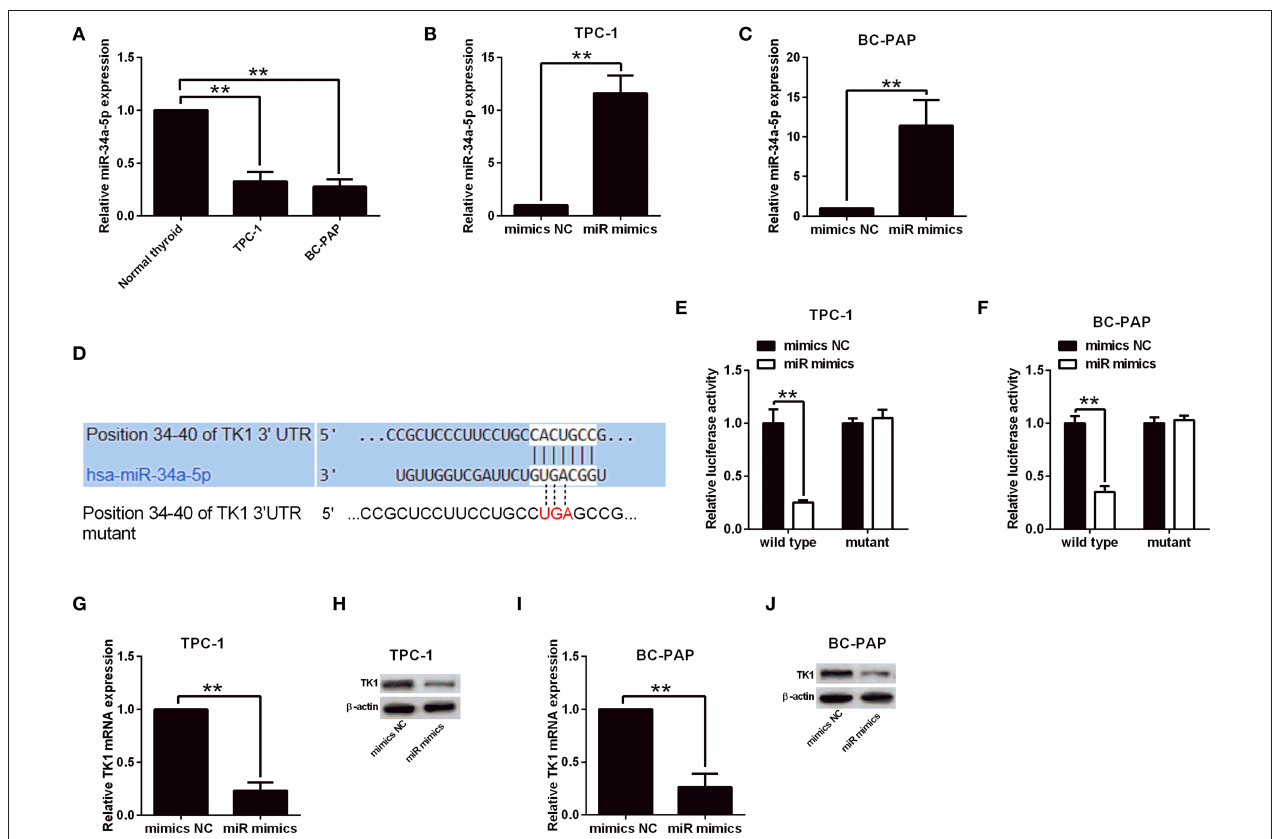
FIGURE 5 | Thymidine kinase 1 (TK1) expression was regulated by miR-34a-5p in thyroid carcinoma cells. (A) Quantitative real-time PCR (qRT-PCR) analysis of miR-34a-5p expression level in normal thyroid follicular epithelial cells, TPC-1 and BC-PAP cells. (B,C) MiR-34a-5p expression in TPC-1 and BC-PAP cells with mimics NC or miR mimics transfection, respectively, by qRT-PCR analysis. (D) Predicted binding sites between TK1 3 ′ UTR and miR-34a-5p by TargetScan tool. (E,F) Luciferase reporter assay was used to investigate luciferase activity of wild and mutant TPC-1 and BC-PAP cells with miRNAs and luciferase reporter vectors cotransfection, respectively. (G–J) qRT-PCR and Western blot were used to detect TK1 mRNA and protein expression levels in TPC-1 and BC-PAP cells with mimics NC or miR mimics transfection, respectively. N = 3; ** P < 0.01.